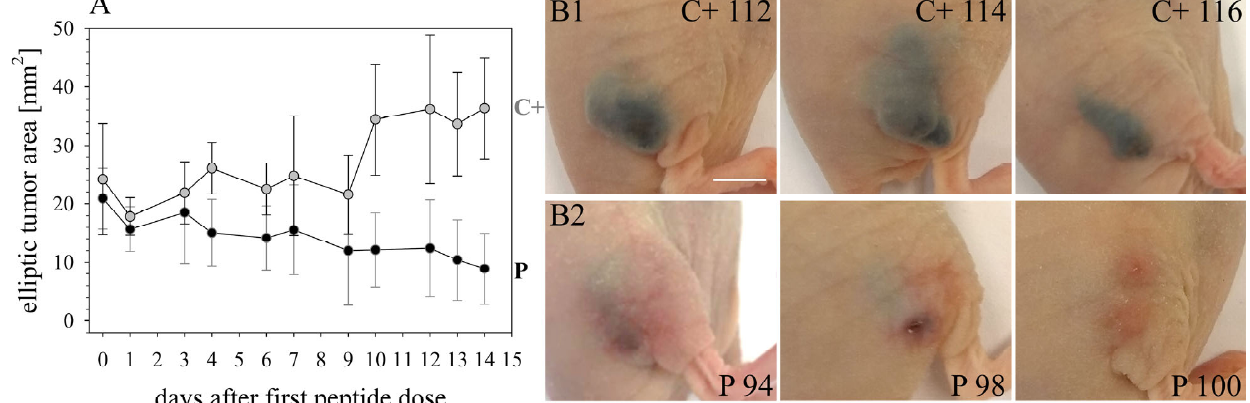
Figure 9. As described in Figure 8, FOXN1 mice were xenotransplanted with the melanogenic cell line MUG ‐ Mel2 subcutaneously in the right flank. Tumors were grown to an approximate size of 20 – 25 mm 2 . Then injection of either 100 μ L buffer PBS in control mice (C+, n = 5) or 0,2 mg peptide (dissolved in 100 μ L PBS) in peptide ‐ treated mice (P, n = 8) started at 11 doses at days 0, 1, 3, 4, 6, 7, 9, 10, 12, 13 and 14. ( A ): Peptide treatment (P) (black circles) with RDP22 strongly and significantly decreases the average tumor size by about 4 ‐ fold compared to control tumors (C+) (grey circles). The data points given reflect 11 dosages applied. ( B1 ): Representative control mice C+ 112, C+ 114 and C+ 116 injected with only buffer PBS show large tumor sizes at day 14. MUG ‐ Mel2 is clearly visible due to intense pigmentation of the melanoma cells. ( B2 ): Representative peptide ‐ treated mice P 94, P 98 and P 100 injected intratumorally with 11 peptide doses of RDP22 (2.2 mg in total) showed strong reduction up to complete clearance of MUG ‐ Mel2 at the end of treatment at day 14, observable by the disappearance of the pigmented tumor cells. Bar represents 0.5 cm.